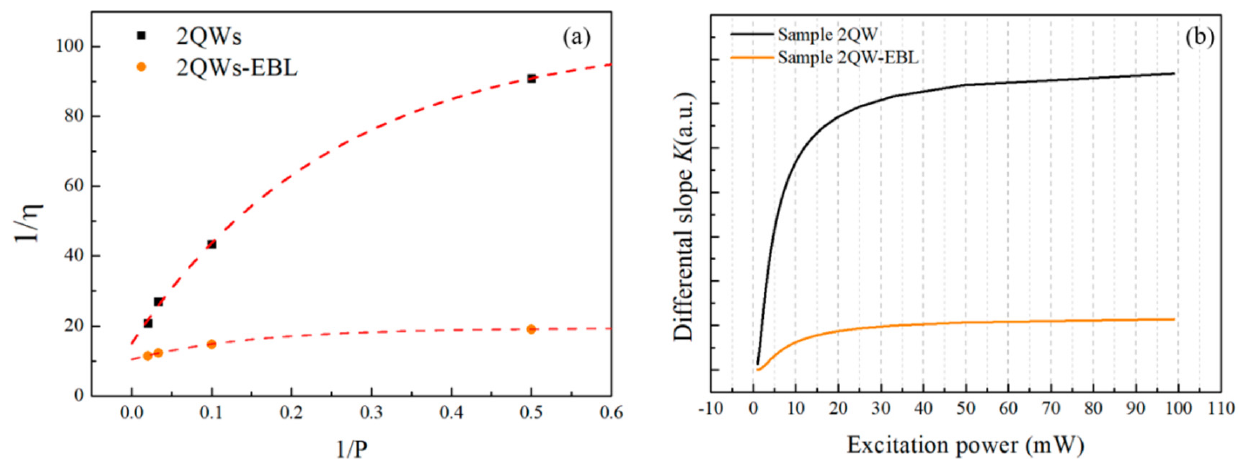
Figure 9. The non-linear fitting results based on the least square method ( a ) and the differential slope K versus excitation laser power ( b